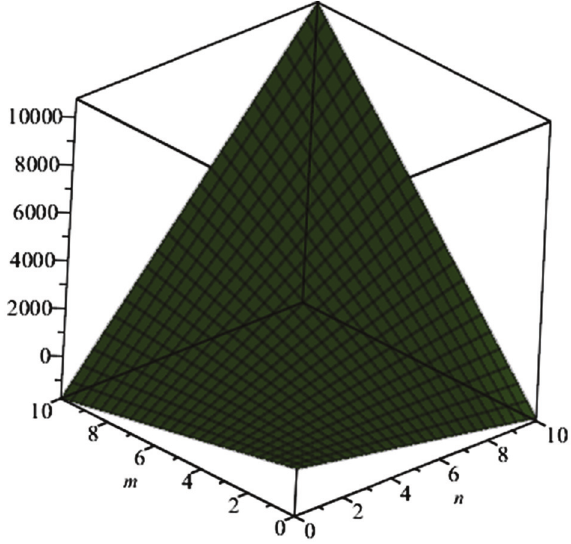
Figure 6: 3D plot of ZC P